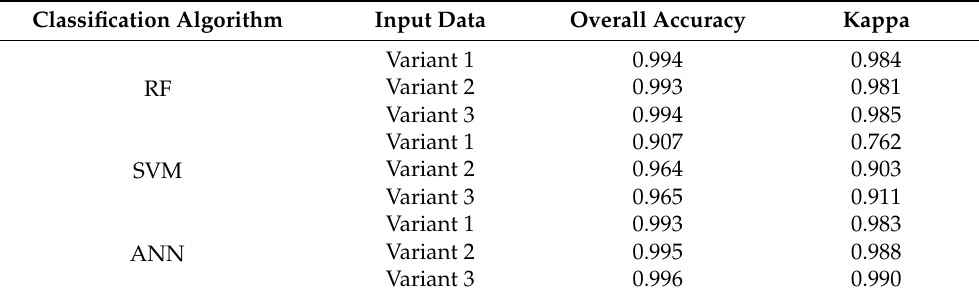
Table 2. Accuracy assessment of the supervised classification results for the creation of vegetation mask.